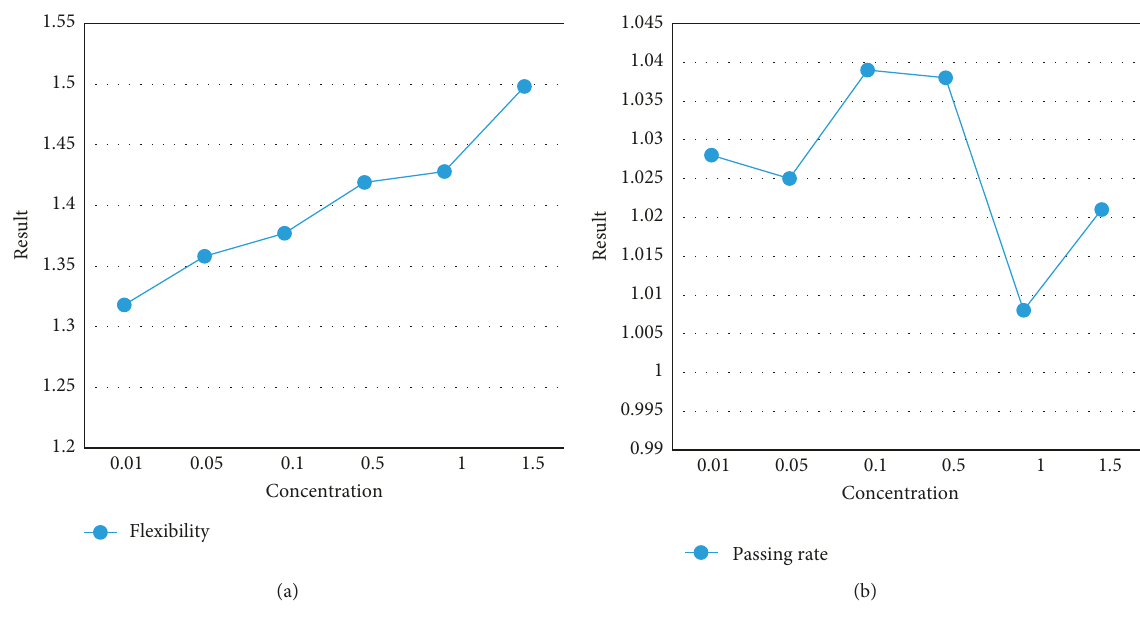
Figure 8: Particle flexibility and